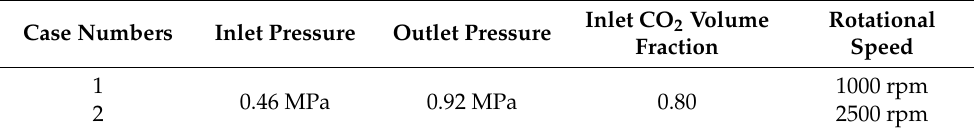
Table 5. Setting parameters of simulations with various rotational